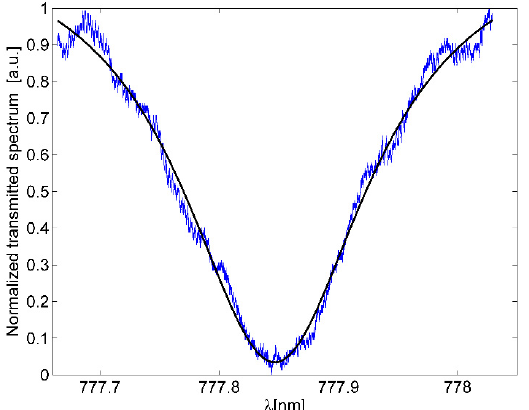
Figure 13. Measured optical resonance and Lorentzian curve fitting (black line) of the proposed ORR M .